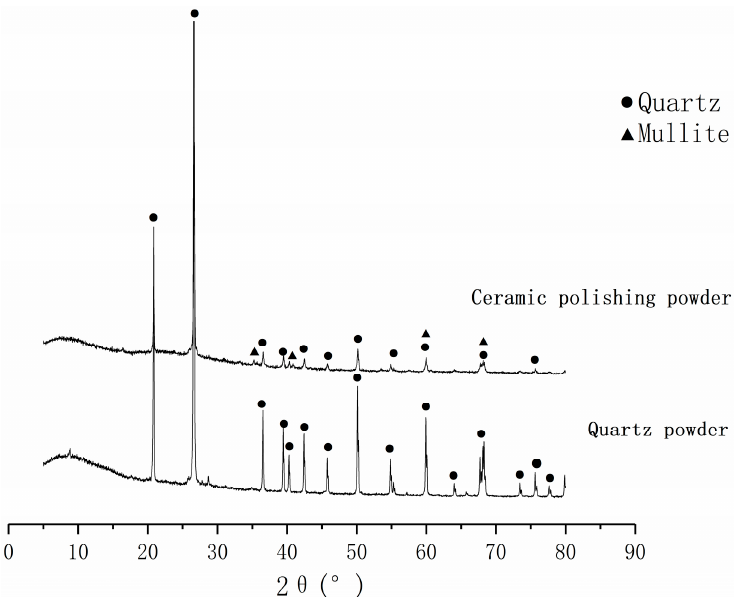
ff raction (XRD) analysis of ceramic polishing powder and quartz powder. Crystals 2019 , 9 , x FOR PEER